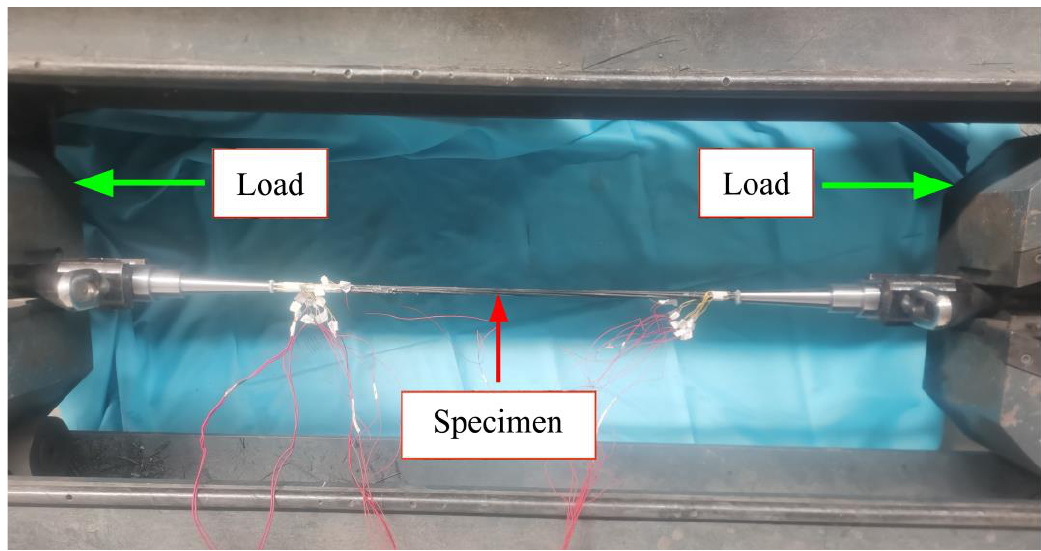
Figure 10. Specimen loading diagram.